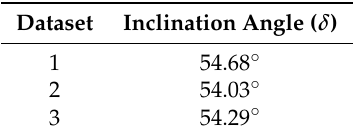
Figure 5. Magnitude of raw and calibrated magnetometer’s measurements while the sensor is randomly rotated by hand. Table 3. Inclination angle calculated for each